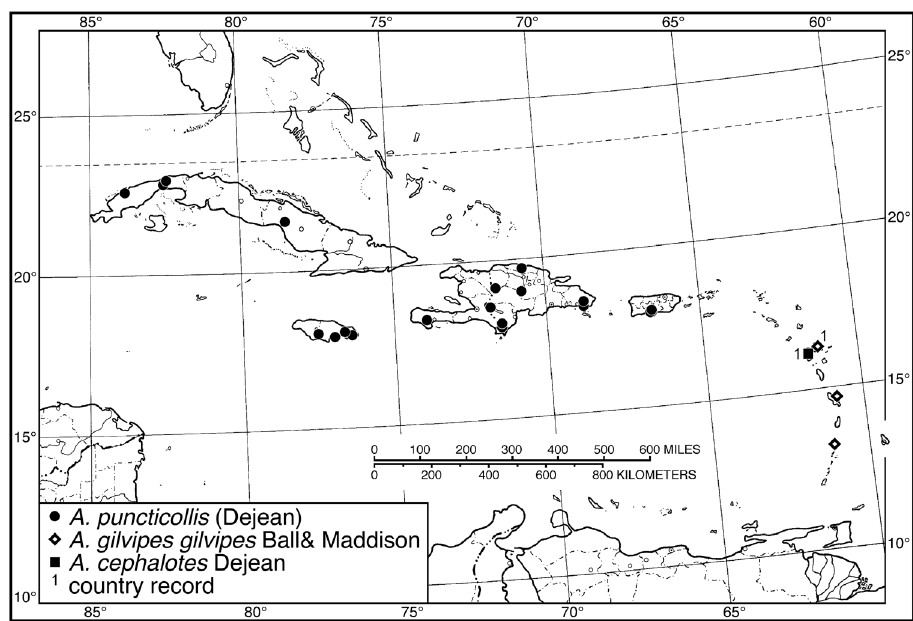
Figure 8. Map of West Indies showing known localities for species of Amblygnathus